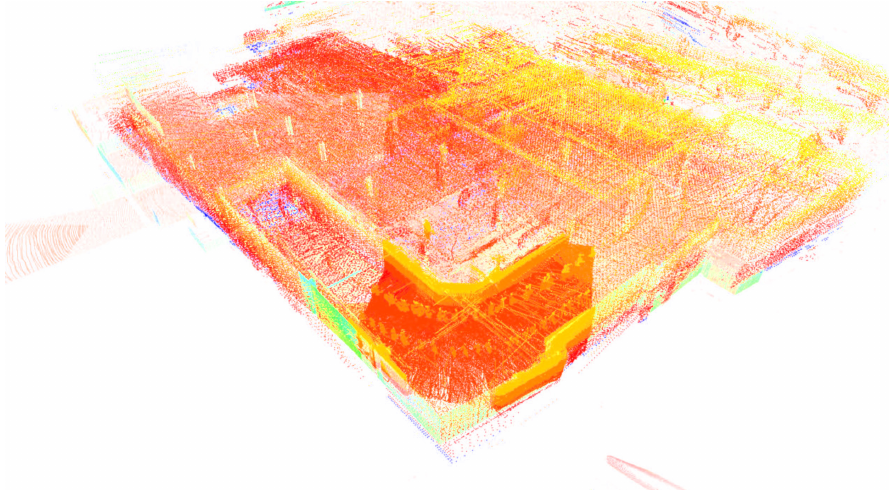
Figure 12. The car park ramp visualized using VILMA data. Two operators are walking up beside the platform. These dynamic effects do not hamper the SLAM-based registration, even if they remain in the final point